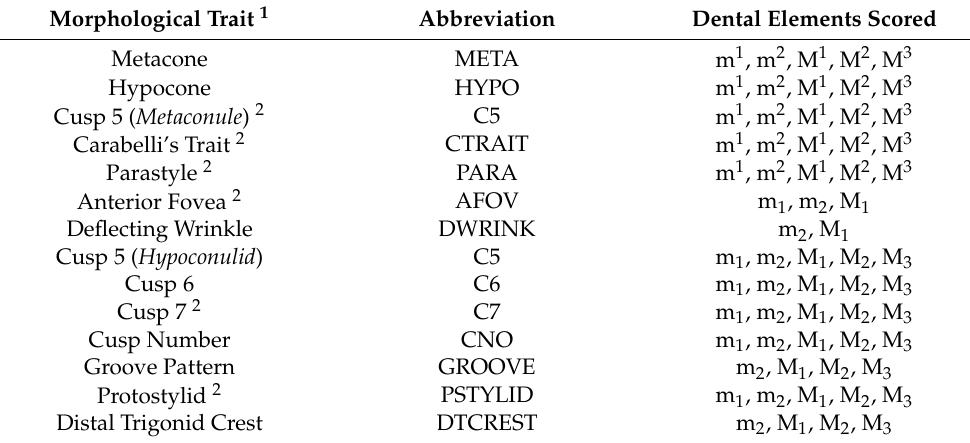
Table 1. Morphological crown traits for UAT data collection. Morphological Trait